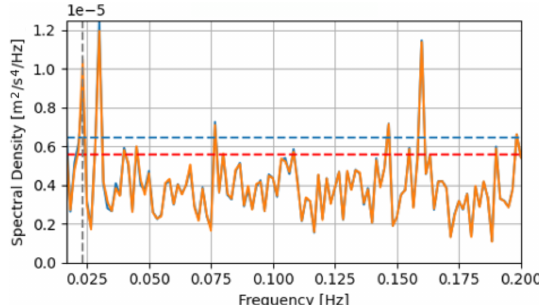
Figure 8. Solid lines indicate raw (blue) and bandpass-filtered (or- ange) spectral density during the first hour of the IWR record. Dashed red line indicates the noise floor of the IMU sensor (from the VectorNav data sheet). Dashed blue line indicates the noise floor derived from the IWR when resting on the floor. The 43s wave sig- nal at ∼ 0.025Hz exceeds both of these noise